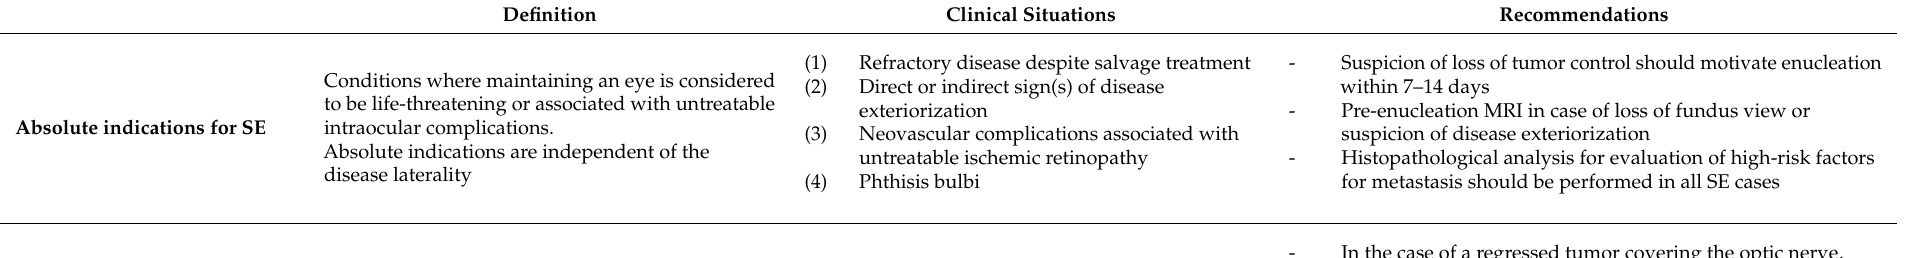
Table 4. Guidelines for secondary enucleation (SE) in the retinoblastoma treatment